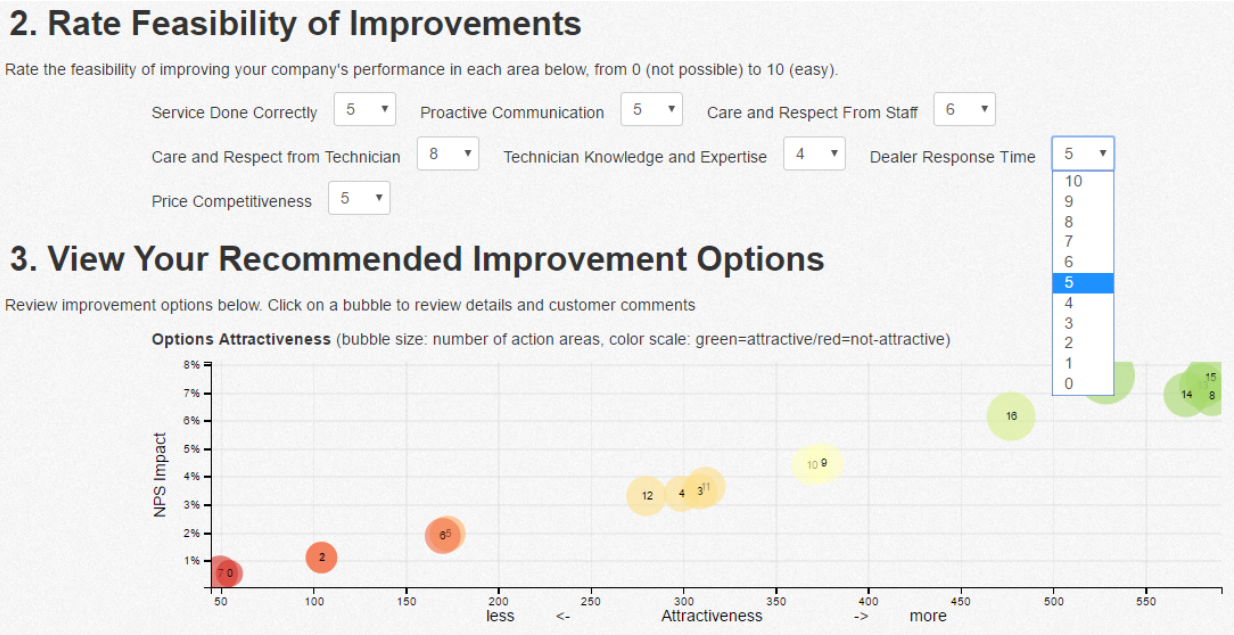
Figure 2. Interactive web-based visualization showing results of the hierarchical clustering procedure—expanding the current client’s dataset with its semantic neighbors. The semantic neighbors of the current company (here, Client9 ) are color-coded and numbered in ascending order of similarity measure.